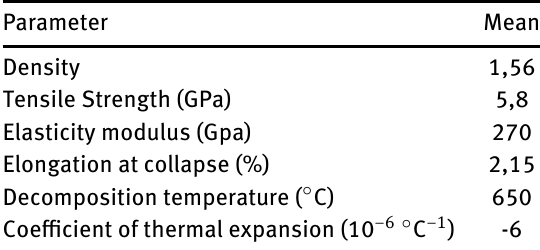
Table 5: Characteristics of PBO